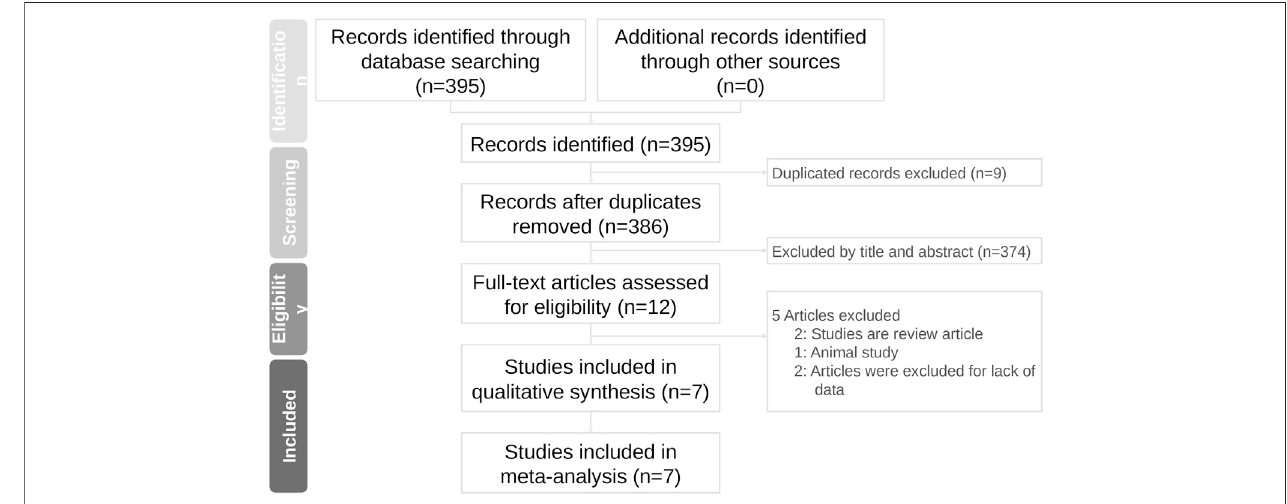
FIGURE 1 | Flowchart of study selection for